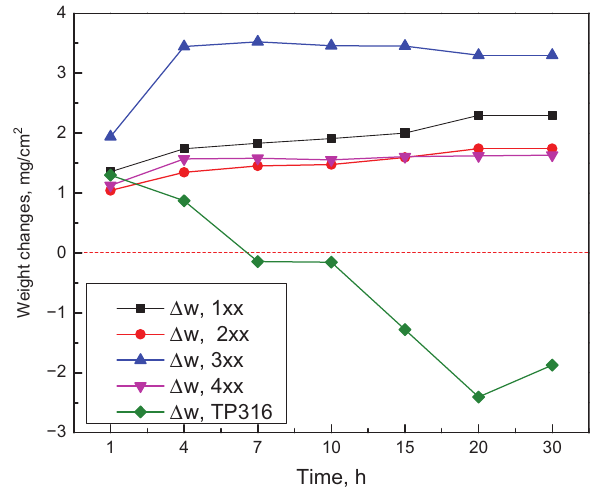
Figure 3: Weight changes during the corrosion process in KCl for four test materials and reference TP316 at